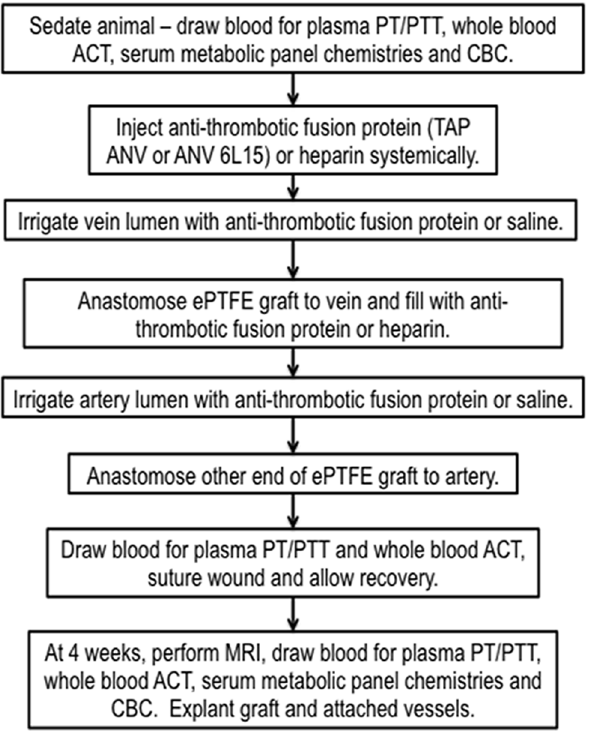
Fig 1. Experimental Procedure Flow Chart. PT = prothromobin time; PTT = partial thromboplastin time; ACT = activated clotting time; CBC = complete blood count. doi:10.1371/journal.pone.0137381.g001 PLOS ONE | DOI:10.1371/journal.pone.0137381 September 11,